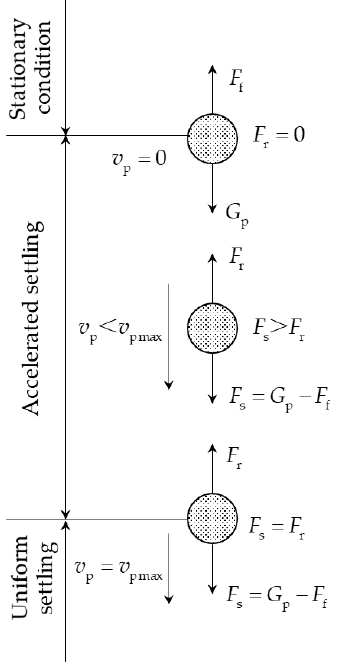
Figure 8. The settling motion process and forces on fly ash particles in air.